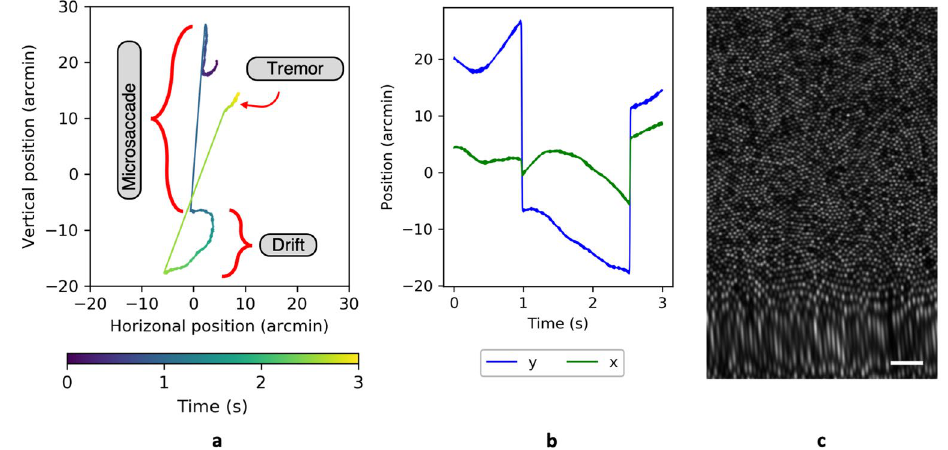
Figure 3. An example three-second eye movement trace, showing three microsaccades interspersed with periods of drift and tremor. Panel ( a ) shows the change in horizontal and vertical position over time, indicated by the colour gradient from blue ( t 0 s ) to yellow ( t 3 s ). Panel ( b ) shows the horizontal (x; green) and vertical (y; blue) components separately. A movie showing a synthetic retina undergoing this motion is given in the supplementary materials S1. Panel ( c ) shows frame 30 from Supplementary Video S3 (diffraction-limited resolution), corresponding to the large and mainly vertical microsaccade at approximately 1 s. This is visible as a stretch at the bottom of the frame. The scale bar represents 10